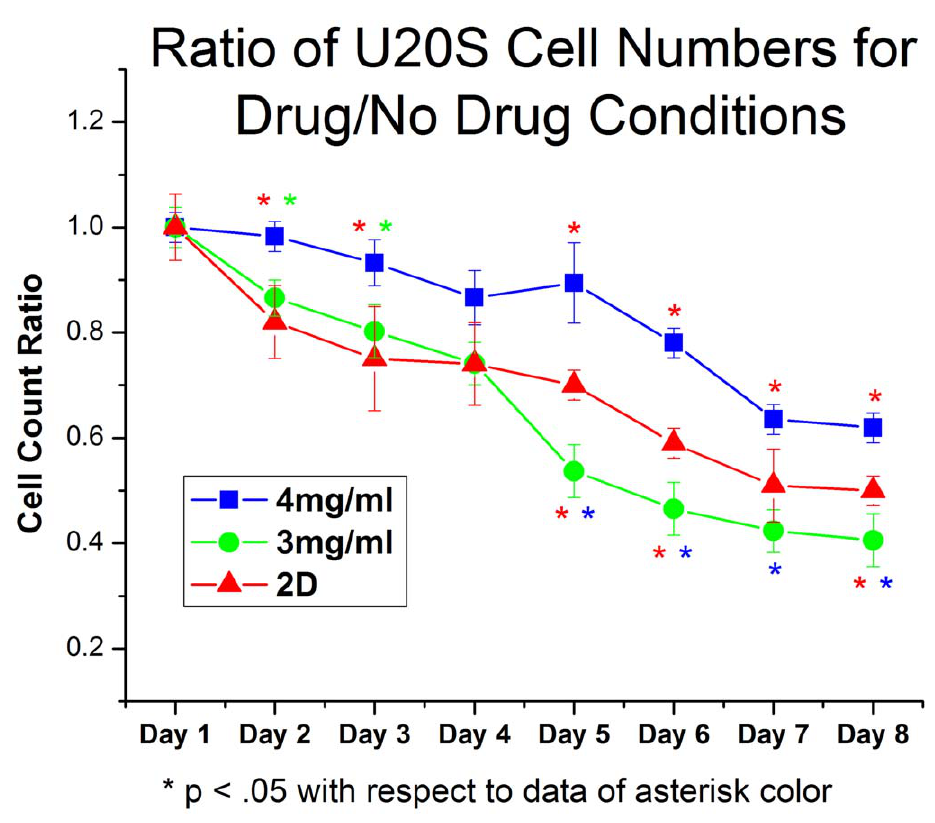
Figure 8. Ratio of U20S cell number in samples treated with PI103 to samples left untreated. Data here is presented as a ratio of cell count in drug treated sample to untreated controls. Cells in 4 mg/ml collagen gels had a 90% cell survival rate after 8 days of drug treatment. Cells were more sensitive to the effects of the drug on 2D tissue culture plastic and in 3 mg/ml gels. Interestingly, cells showed similar behavior in 3 mg/ml and 4 mg/ml gels when untreated, but had a markedly different response to PI103. All Day 8 data points are significantly different (p , .05).